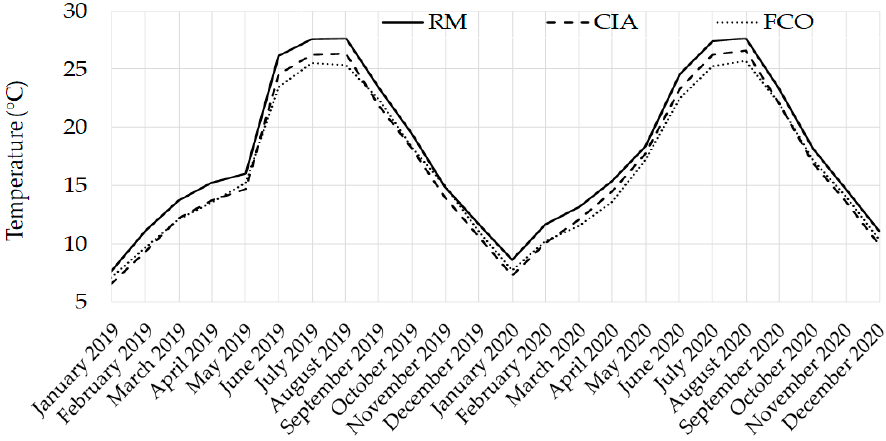
Figure 3. Monthly temperature values monitored in Rome, Fiumicino and Ciampino.